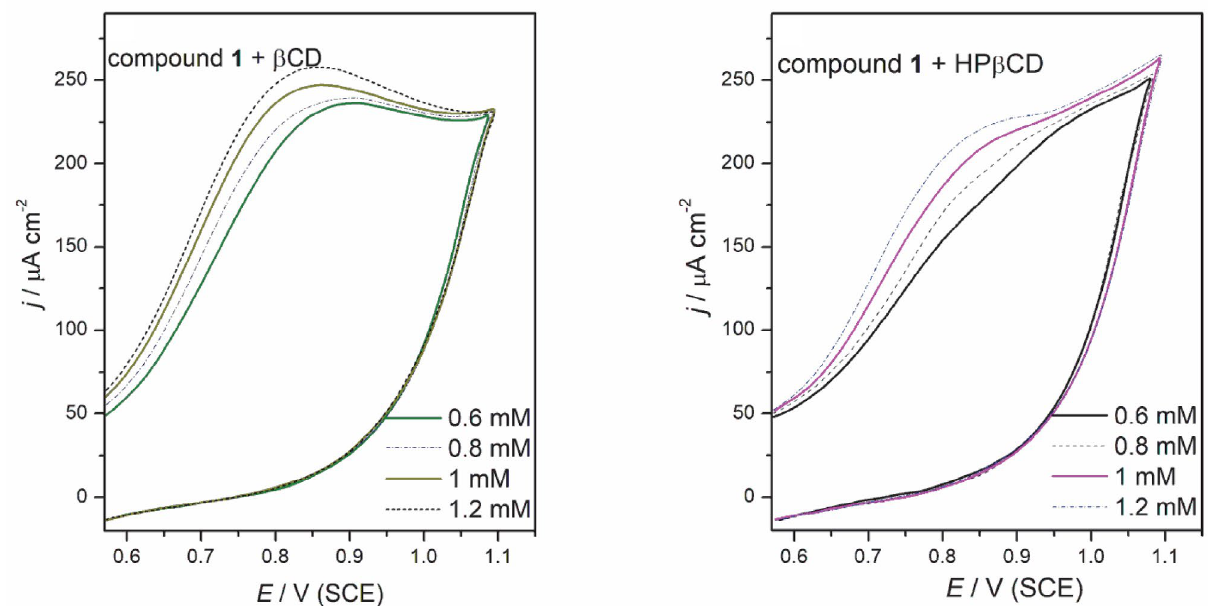
Figure 4 . CVs of Au electrode in 0.05 M NaHCO 3 in the presence of compound 1 ( c = 1 mM) complexated with βCD (A) and complexated with HPβCD (B). Concentrations of CDs are 0.6, 0.8, 1 and 1.2 mM. v = 100 mV s –1